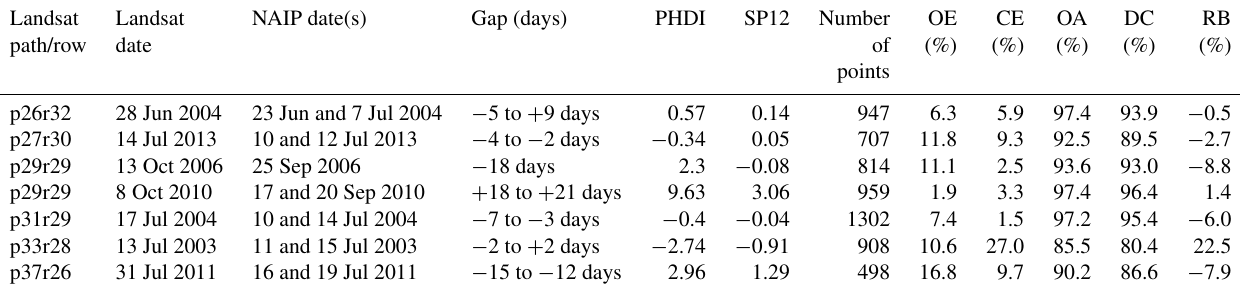
Table 2. Landsat images and corresponding National Agricultural Imagery Program (NAIP) images used to validate the Landsat surface water extent maps. Accuracy is presented here by Landsat image. PHDI – Palmer Hydrological Drought Index, SP12 – 12-month Standardized Precipitation Index, OE – omission error for water, CE – commission error for water, OA – overall accuracy, DC – Dice coefficient, and RB – relative